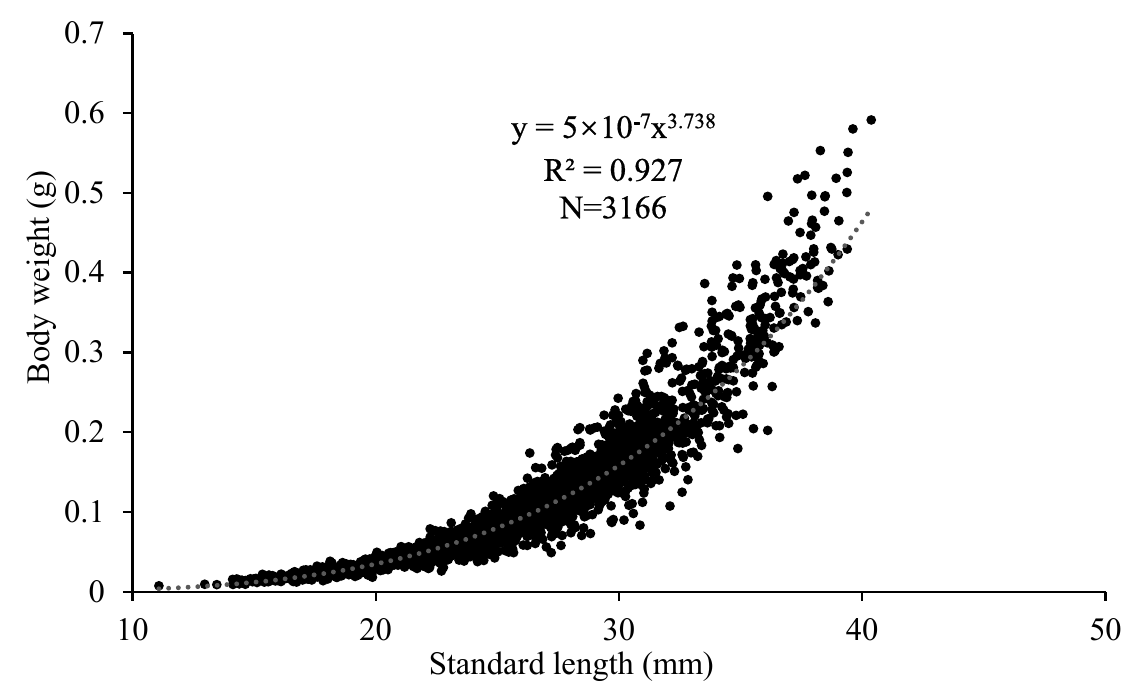
Figure 4. Length–weight relationship of larval and juvenile Japanese anchovy off the Pacific coast of Japan in 2020–2021.